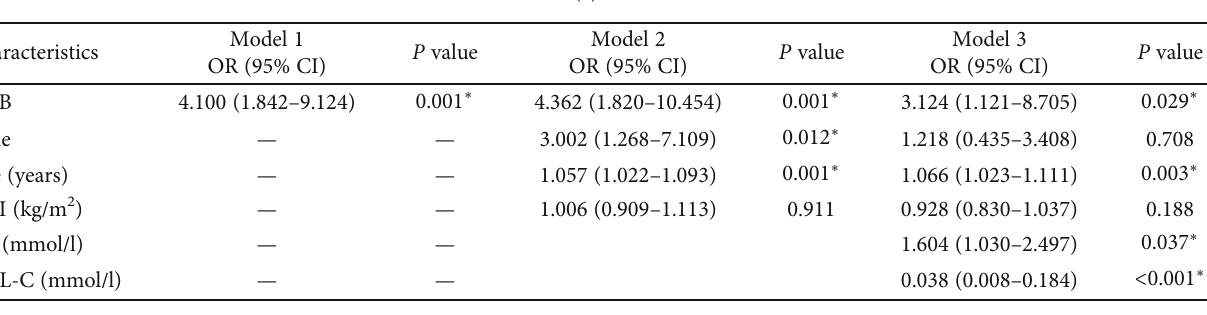
Table 2: Logistic regression analysis of the association of enterotypes with T2D